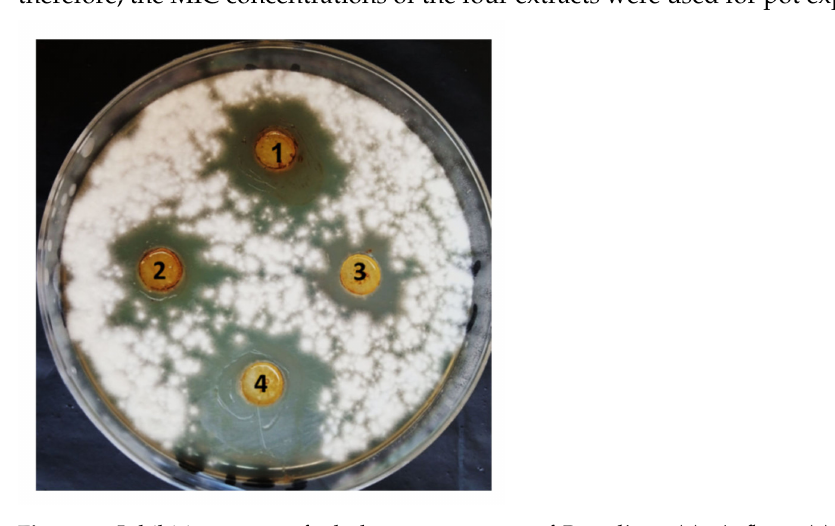
Figure 2. Inhibition zones of ethyl acetate extracts of P. oxalicum ( 1 ), A. flavus ( 2 ), A. niger ( 3 ) and